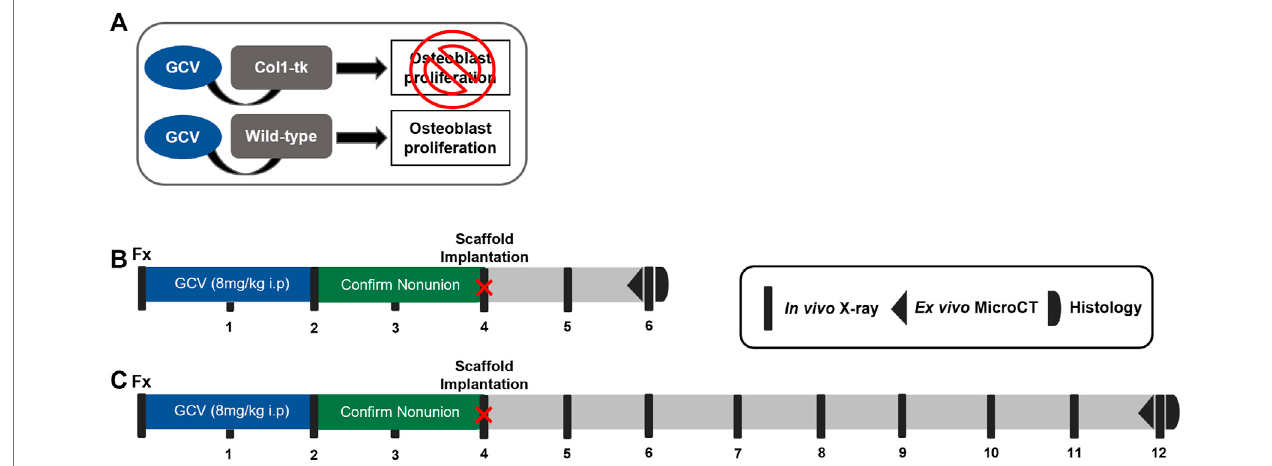
FIGURE 1 | Schematic of the establishment of a non-union and scaffold implantation in Col1-tk mice. (A) While receiving the GCV drug, any Col1-tk + cells within the mouse that are proliferating will selectively die. Non-proliferating osteoblasts will remain alive. Once the drug is removed, any proliferating osteoblasts will not die. (B, C) Col1-tk mice at 12 weeks of age were subjected to a femur fracture, followed by daily GCV administration for 2 weeks to blunt the healing response. The mice were monitored from week 1 – 4 by X-ray to con fi rm minimal callus formation. At 4 weeks post-fracture, an additional surgery was performed, and the scaffolds were implanted. The mice were monitored by X-ray for 2 – 8 weeks post-scaffold implantation until sacri fi ce. The outcomes included micro-CT and